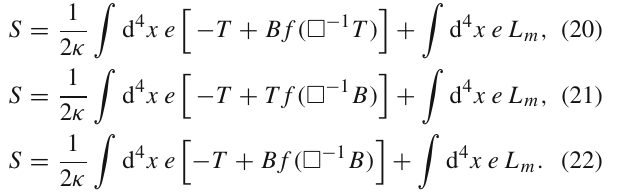
Figure 1 is a comprehensive diagram representing all the theories that can be recovered from the action (13). Here, we have not considered unnatural couplings like R f ( (cid:2) − 1 T ) or T f ( (cid:2) − 1 R ) because R and T , B are quantities defined in different connections, so mixed terms like R f ( (cid:2) − 1 T ) are badly defined. The above half part of the figure represents different non-local teleparallel theories and the below part of it, the standard curvature counterpart. As is easy to see, only TEGR and GR dynamically coincide while this is not the case for other theories defined by T , R and B . From a fundamental point of view, this fact is extremely relevant because the various representations of gravity can have dif- ferent dynamical contents. For example, it is well known that f ( T ) gravity gives second order field equations, while f ( R ) gravity, in metric representation, is fourth order. These facts are strictly related to the dynamical roles of torsion and curvature and their discrimination at fundamental level could constitute important insight in really understanding the nature of the gravitational field (see [29] for a detailed dis-